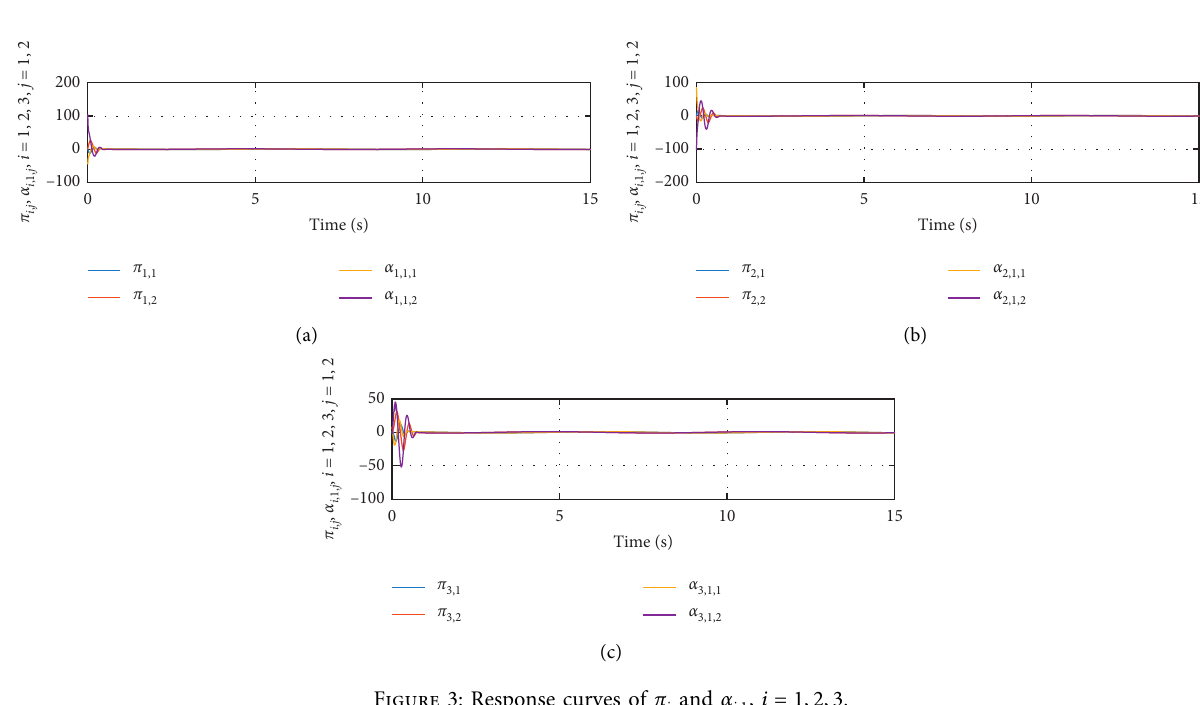
, i � 1 , 2 , 3. i and α i, 1